Question: Provide a one-line summary of what is displayed.
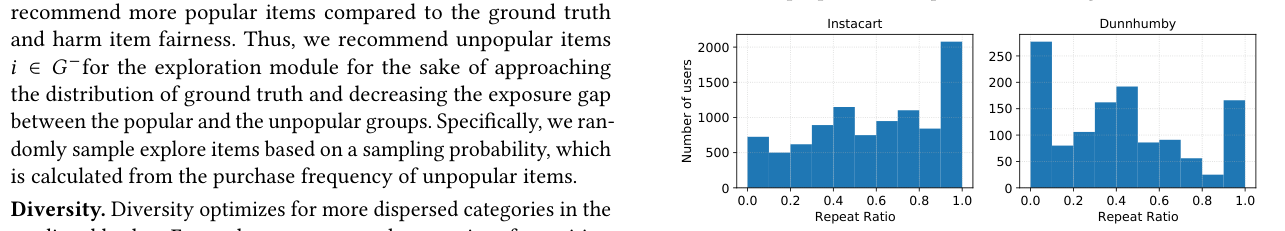
Answer: Distribution of users across different repeat ratios for Instacart and Dunnhumby.